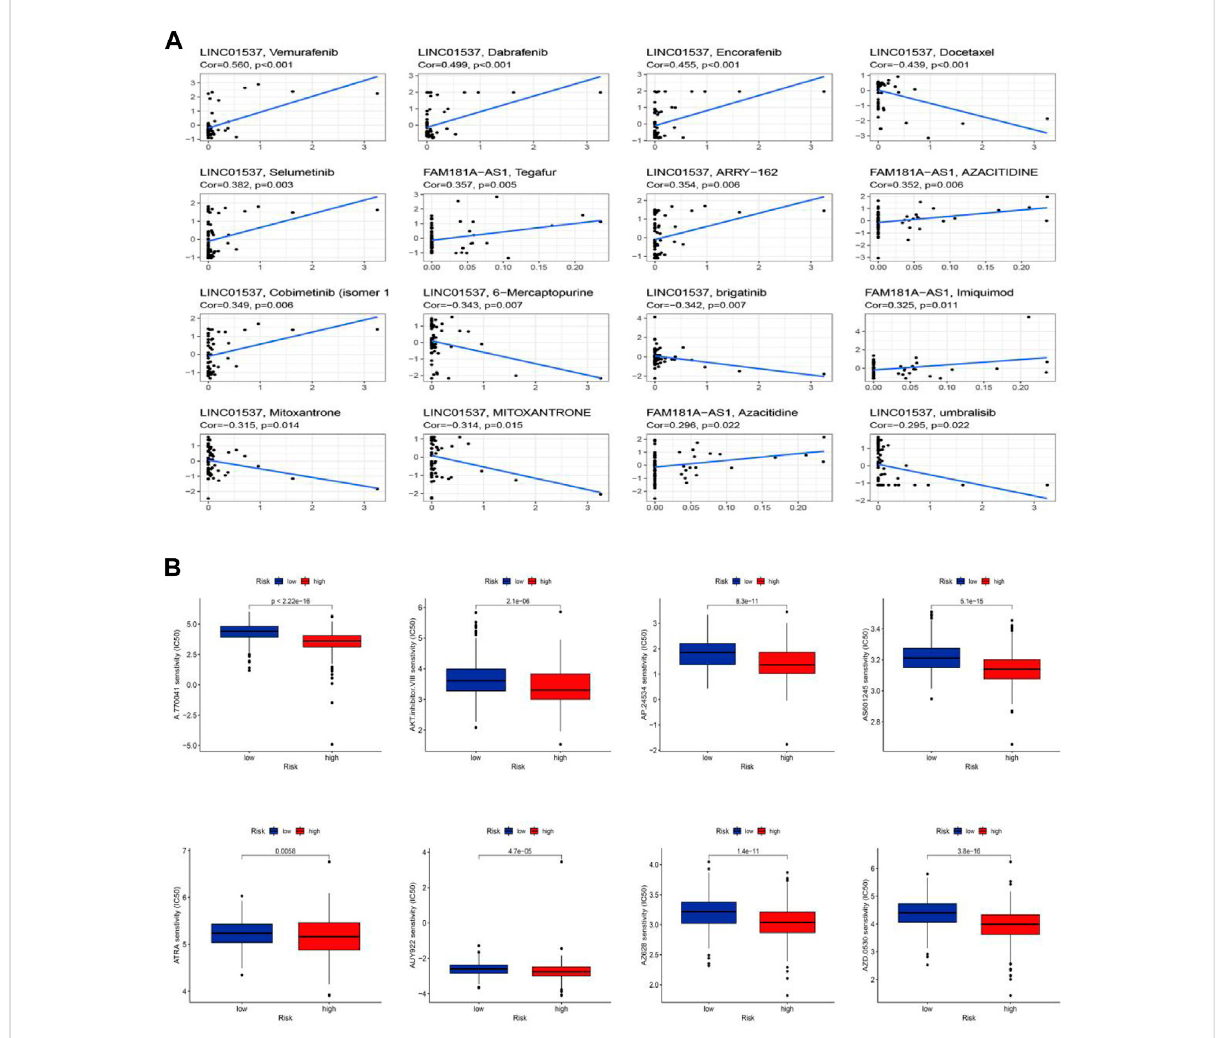
FIGURE 10 Sensitivity of chemotherapy drugs. (A) The high correlation drugs targeting 11 cuproptosis-related lncRNAs. (B) Drug sensitivity